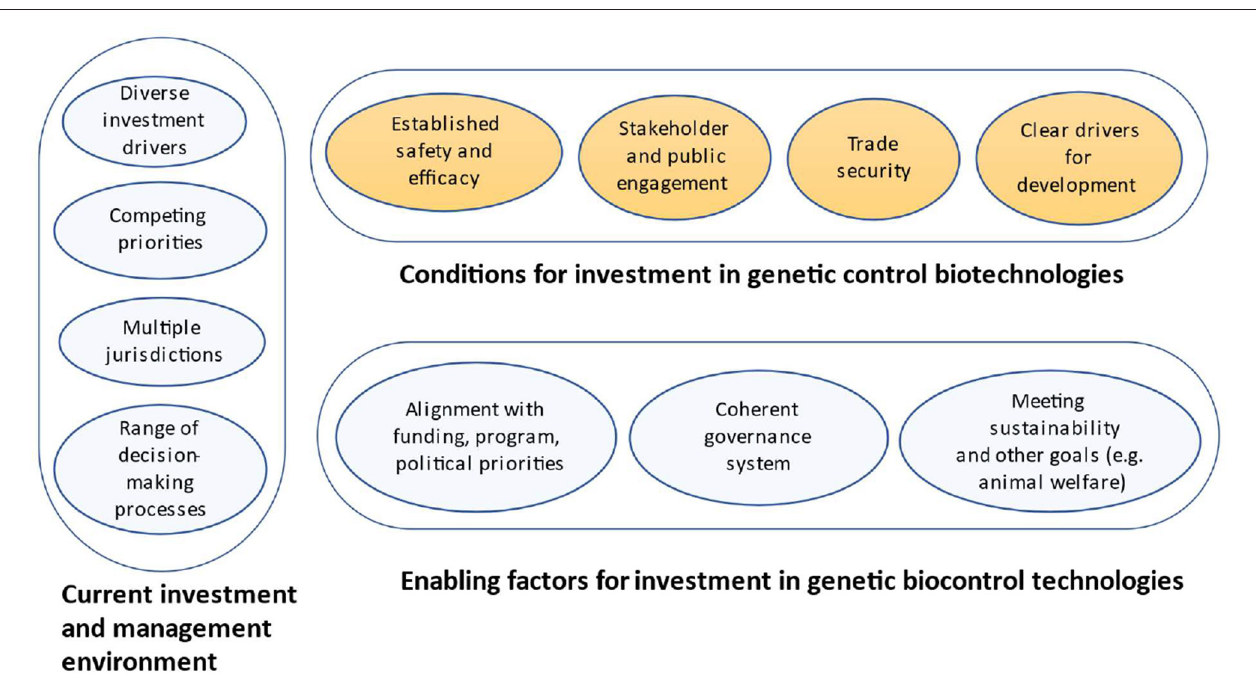
FIGURE 1 | Investment decision framework for genetic biocontrol of vertebrate pests in Australia, with conditions for investment highlighted in orange.